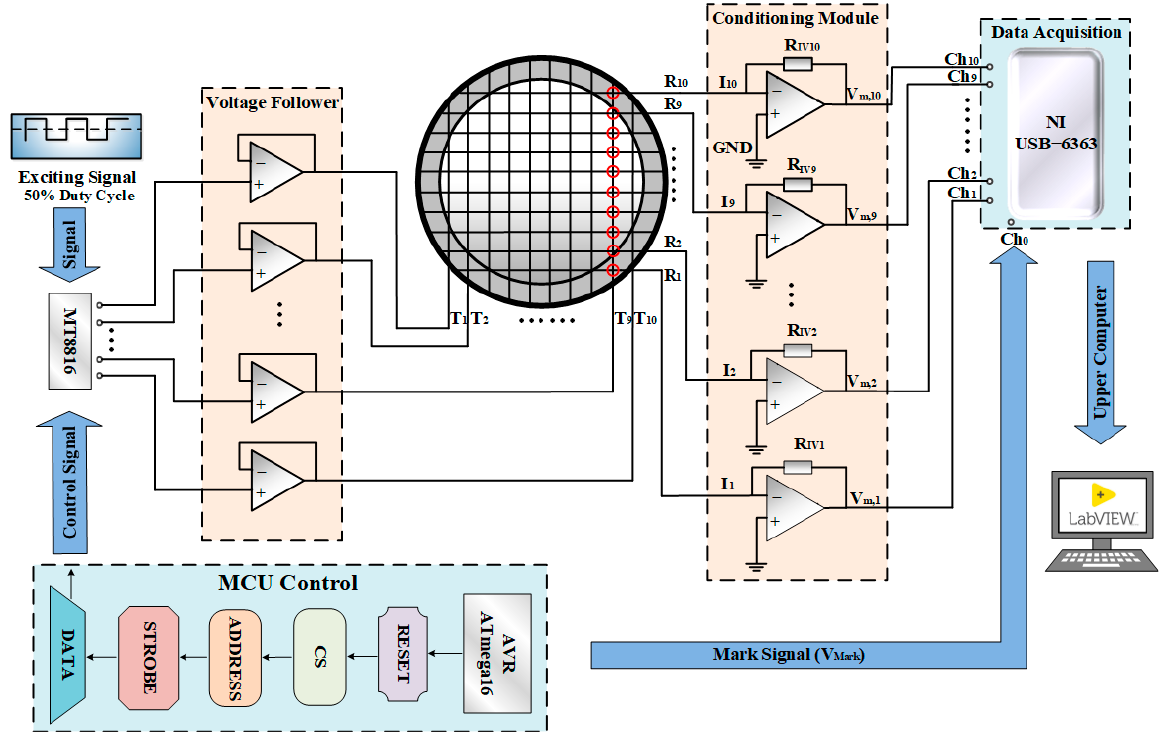
Figure 1. The schematic of the wire ‐ mesh sensor system.